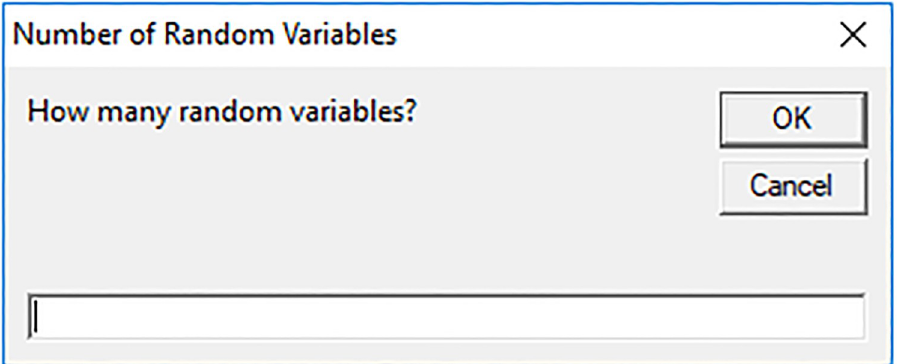
Fig 2. Window associated to the number of random variables.